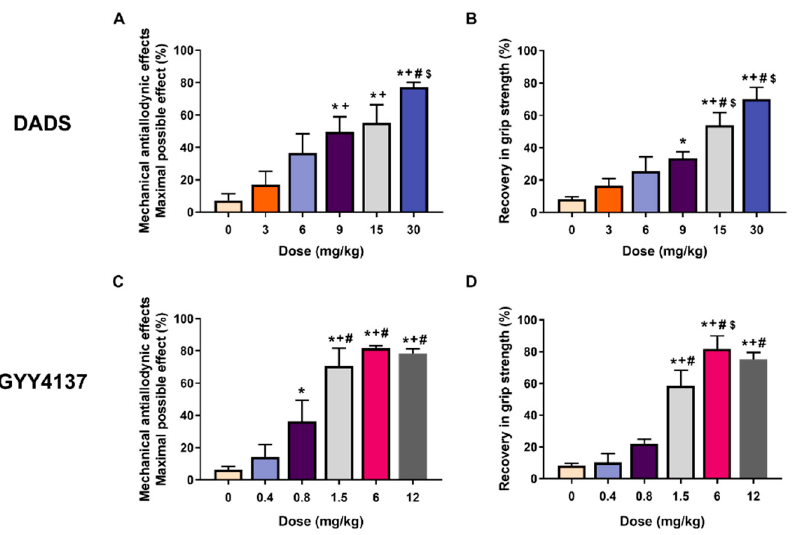
Figure 1. The administration of DADS and GYY4137 reduced the mechanical allodynia and grip strength deficit generated by MIA in a dose-dependent manner. The mechanical antiallodynic effects ( A , C ) and the recovery in grip strength ( B , D ) induced by different doses of DADS or GYY4137 (mg/kg) are shown. For each test and drug, * denotes significant differences compared to SS (0 mg/kg) treated mice; + compared with the effects of low doses of DADS (3 mg/kg) or GYY4137 (0.4 mg/kg); # compared with the effect of 6 mg/kg of DADS or 0.8 mg/kg of GYY4137 and $ compared with